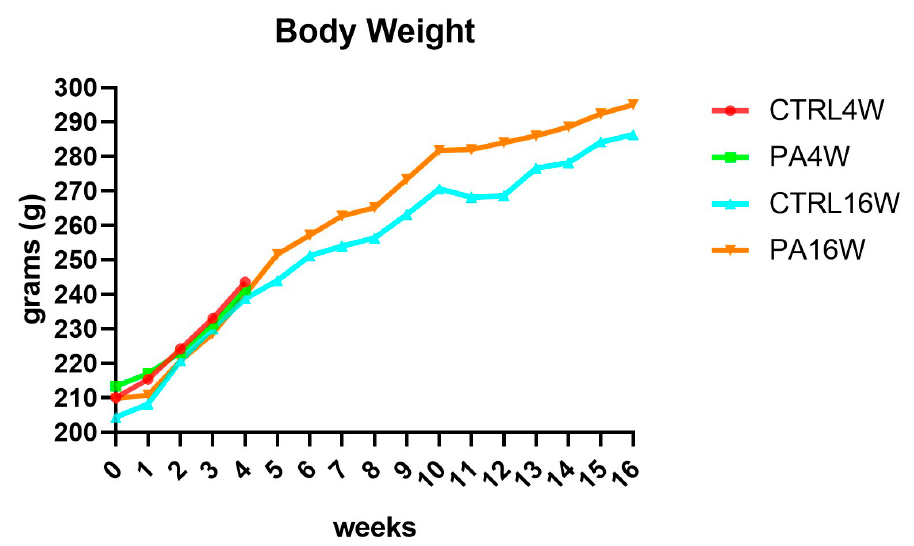
Figure 3. Body weight variations over 16 weeks, showing a physiological increase in all groups. The differences between groups, analyzed by two-way ANOVA followed by Tukey’s multiple comparison post hoc test, are not significant, as expected ( p > 0.05). CTRL4W, control sedentary rats sacrificed at 4 weeks; PA4W, rats performing physical exercise sacrificed at 4 weeks; CTRL16W, control sedentary rats sacrificed at 16 weeks; PA16W, rats performing physical exercise sacrificed at 4